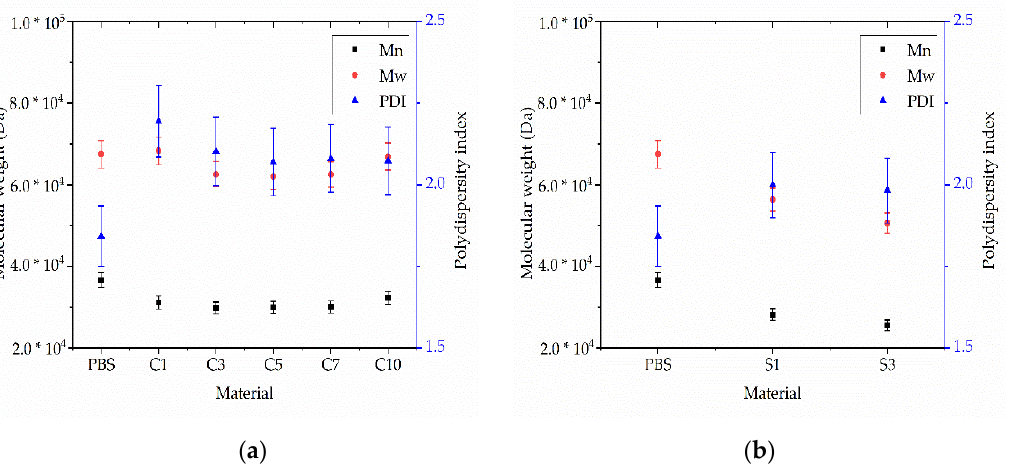
Figure 21. Weight average relative molecular weight (Mw), number average molar mass (Mn) and polydispersity index (PDI) of ( a ) PBS-curcumin compound fibers and ( b ) PBS-silver compound fibers. Data are means ± standard deviations ( n = 3).